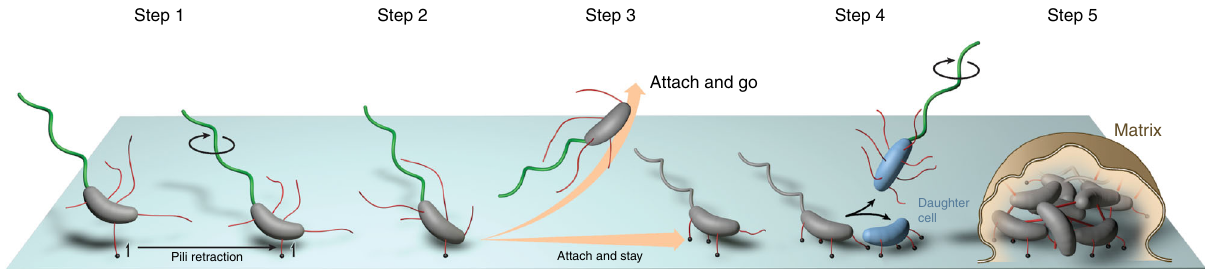
Fig. 8 Model of MSHA-mediated initial surface-attachment dynamics of V. cholerae . A model through which intracellular c-di-GMP interactions with the extension ATPase MshE, modulates extension and retraction activity of the MSHA pilus to facilitate near-surface motility patterns and V. cholerae surface attachment. (Step 1) MSHA elaborated on the cell surface (red) facilitate initial interactions of a motile cell (gray) with the surface. Black dots in the model are indicative of MSHA interactions with the surface. As motile cells have low levels of intracellular c-di-GMP, conditions are primed to promote MSHA PilT-mediated retraction via reduced MshE extension activity. At this stage, fl agellar motion (green) can continue (indicated by black circle around the fl agellum) resulting in near-surface orbiting motility. (Step 2) MSHA pilus retraction aids in facilitating initial surface interactions and attachment, and